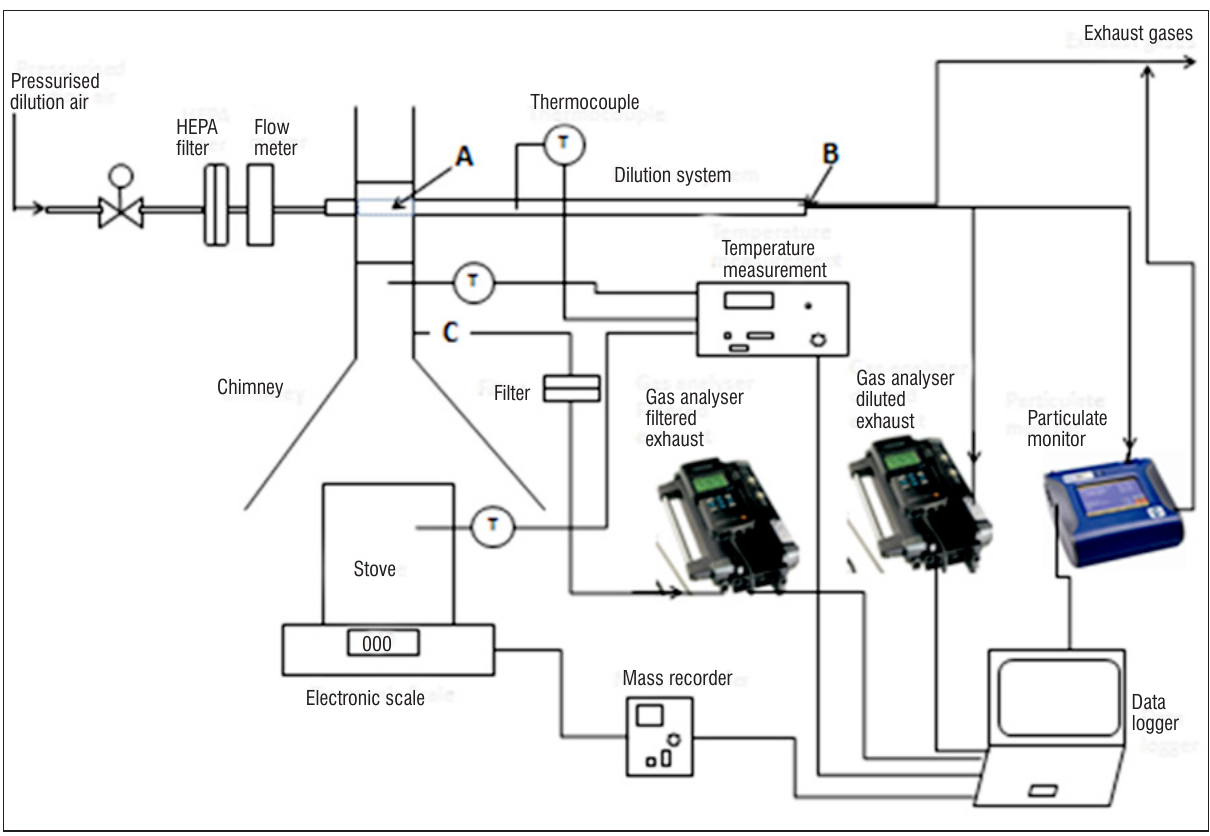
Figure 2: Schematic illustration of the SeTAR stove testing rig, showing the mixing point (A) where the exhaust is mixed with filter compressed air for dilution; and the sampling point (B) where the diluted exhaust is channelled to the monitoring